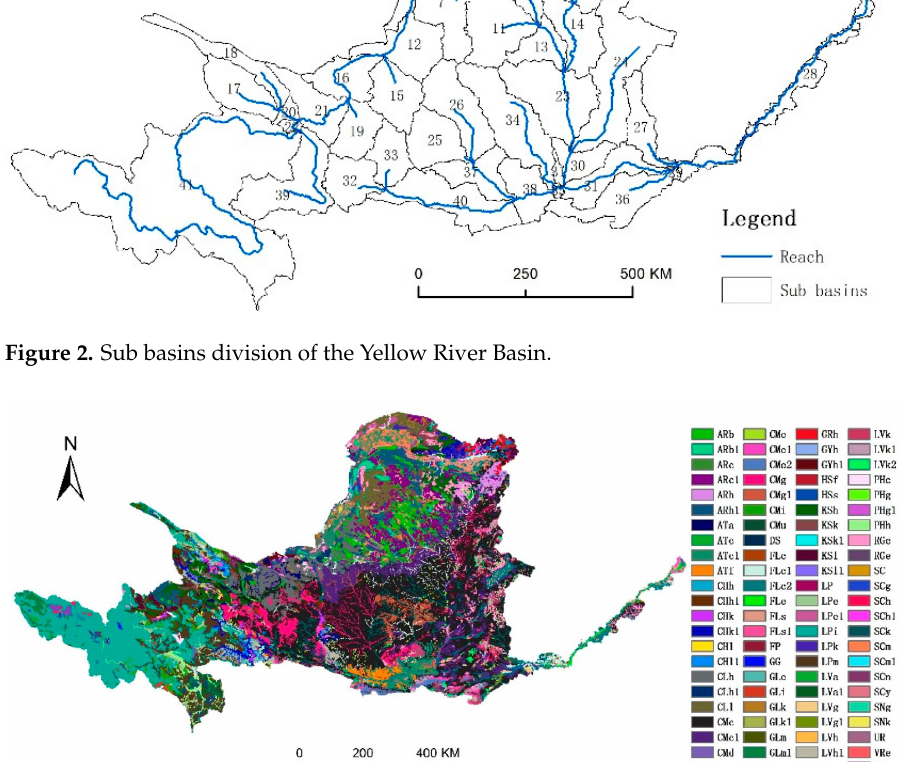
Figure 3. Soil types in the Yellow River Basin (Note: the number after the abbreviation of soil type indicates that the soil type is the same, but the soil physical parameters are